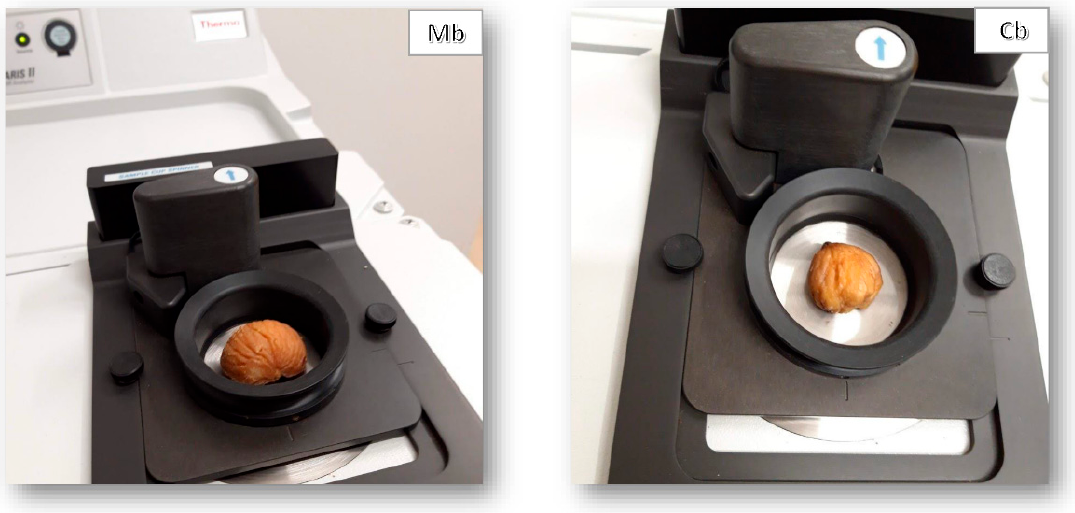
Figure 1. Vis-NIR spectral measurement of boiled Marrone chestnut (Mb) and boiled Sweet chestnut (Cb).